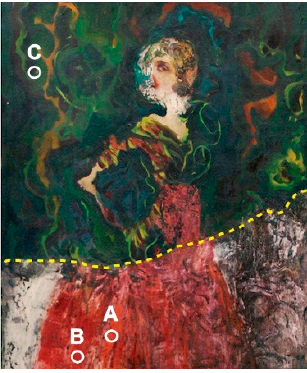
Figure 9. Overpainted modern oil painting by anonymous.